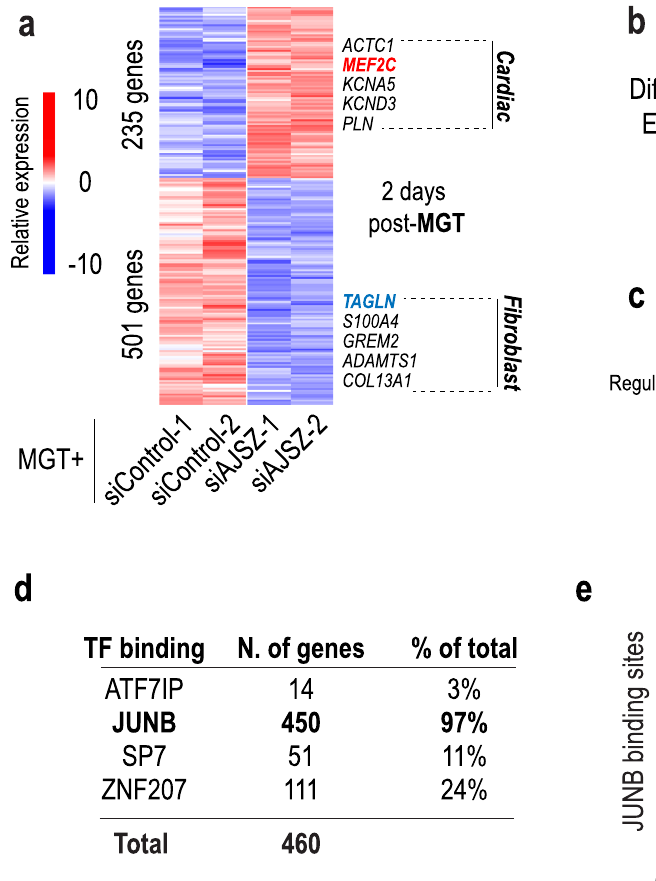
biological terms enriched for the 460 DE and core promoter-bound genes. d Breakdownof thepercentageof DE and core promoter-bound genescontaining ATF7IP, JUNB, SP7, or ZNF207 binding sites. e ChIP-seq tracks for JUNB binding sites. f , g GenomebrowserviewsshowingJUNBbindingatTAGLN( f )andatMEF2C core promoter regions ( g ) in